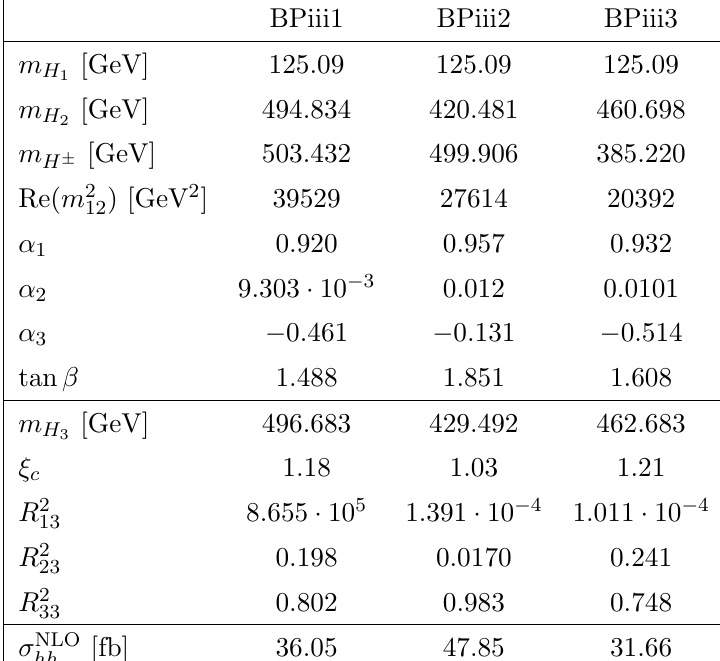
. Line 14: the i 3